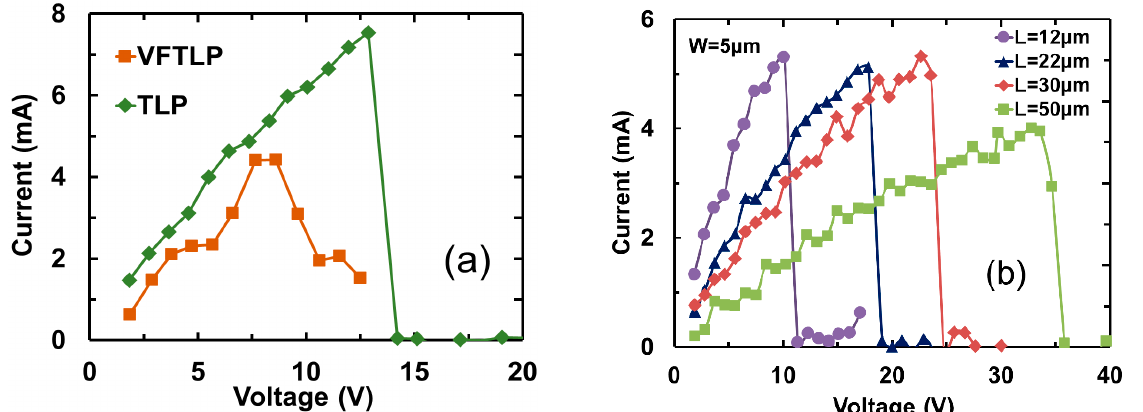
Figure 31. Measured transient ESD I-V characteristics for graphene nanoribbon samples: ( a ) TLP versus VFTLP zapping, and ( b ) TLP I-V curves for GNR wires of different lengths showing impacts on V C [50].